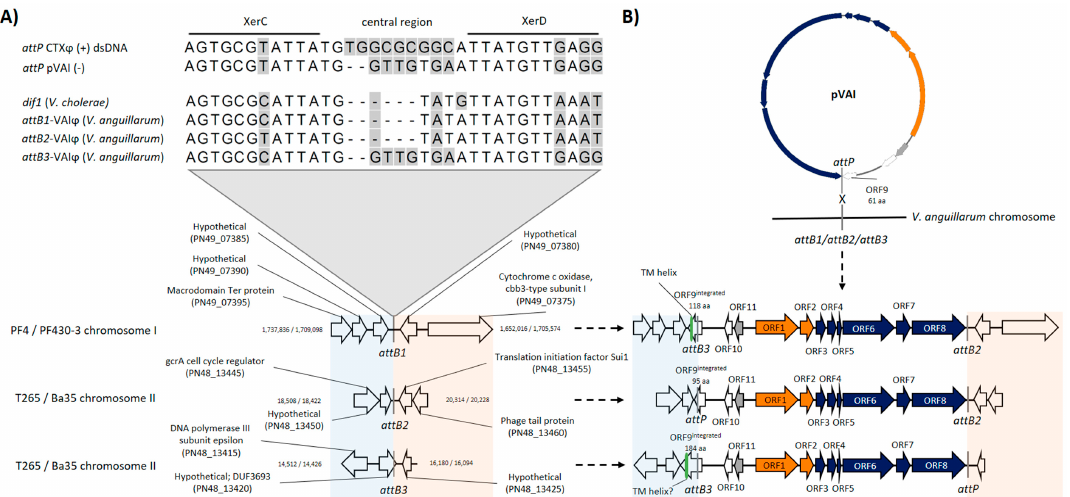
Figure 4. pVAIs attP and insertion of VAI φ genome in Vibrio anguillarum chromosomes. ( A ) Alignment of CTX φ and pVAIs putative attP plus V. cholerae dif1 [39] and V. anguillarum dif1 -like ( attB ) sites and their genomic positions as indicated by a gray line in chromosomes of V. anguillarum hosts where a VAI φ genome insertion was observed. The extended lines indicate XerC and XerD binding sites and are separated by a central region. Vertical lines indicate alignment gaps and non-identical nucleotides are shaded. ( B ) The fate of VAI φ genome insertions in V. anguillarum . The assumed strand exchange altered the att sites upon VAI φ genome insertion into attB1 in PF4- zot -prophage − -VAI φ and resembled attB sites observed in V. anguillarum strains Ba35 and T265. The presumed strand exchange conserved the observed attP and attB sites following VAI φ genome insertion into attB2 and attB3 in strains Ba35 and T265. Open arrows represent ORFs oriented in the transcription direction and the color indicate the putative functions of structure-and-assembly, replication, regulation and other / hypothetical for blue, orange, gray and white, respectively. The green rectangles in (B) represent the presence of predicted transmembrane domains in ORF9 intergrated (Table